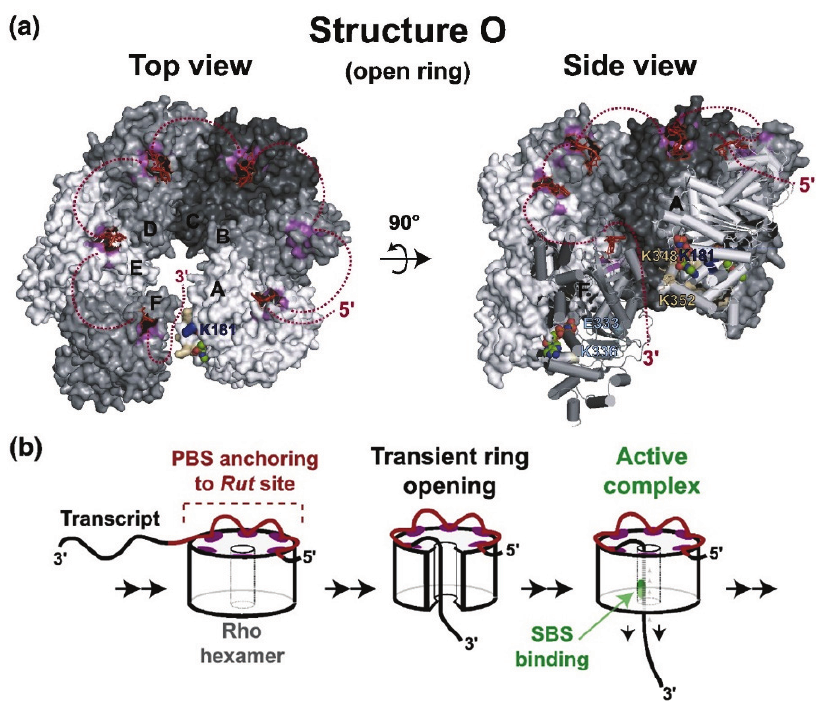
Figure 2. Structure and movement of